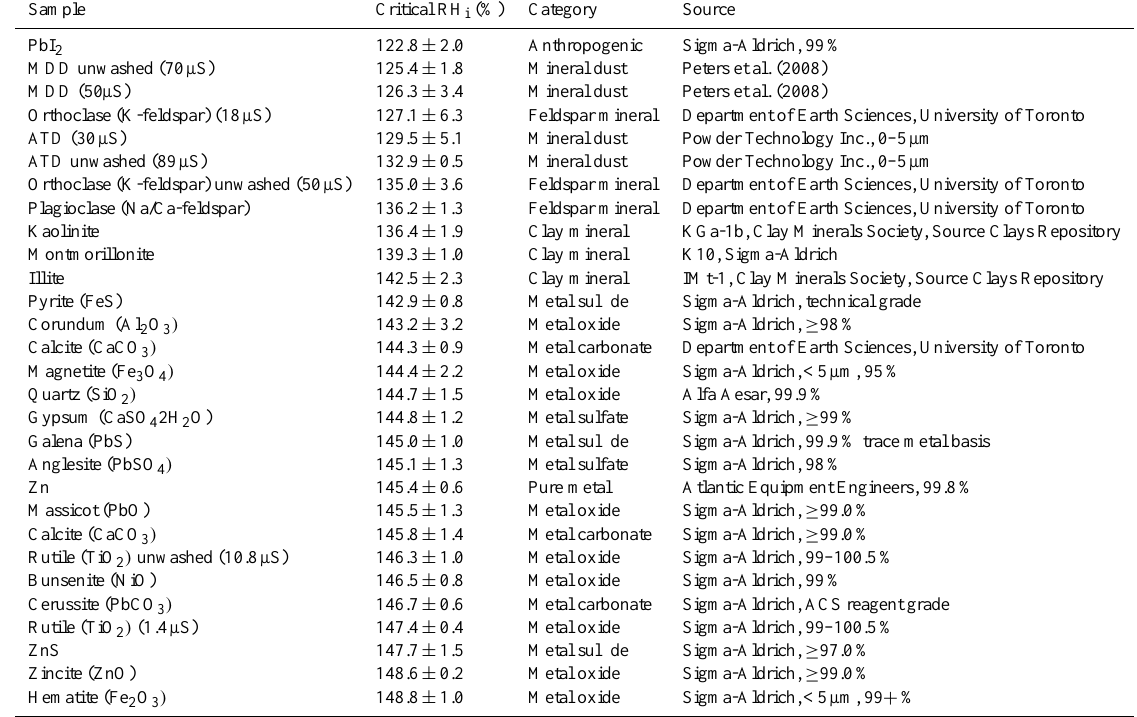
Table 1. Tested substances in order of increasing critical RH i for deposition activation of 0.1% of 200nm particles at − 40 ◦ C. The electrical conductivity (µS) of the suspensions is indicated in parentheses for MDD, ATD, orthoclase, and TiO 2 after the sample